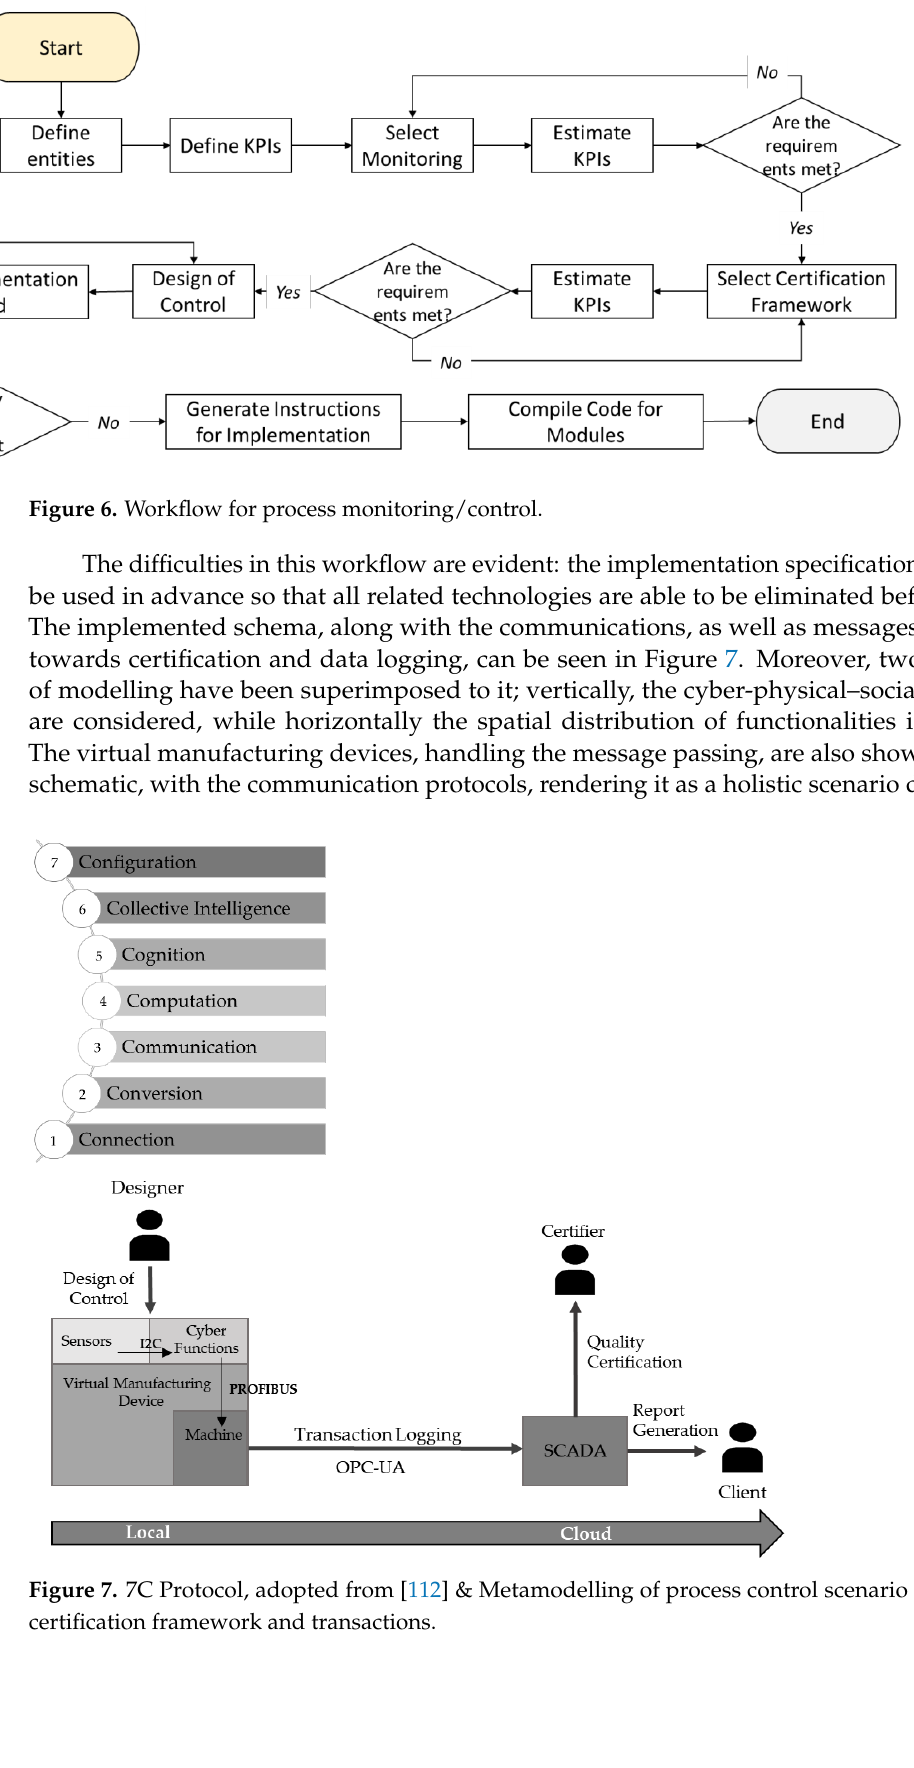
Figure 7. 7C Protocol, adopted from [112] & Metamodelling of process control scenario including certification framework and transactions